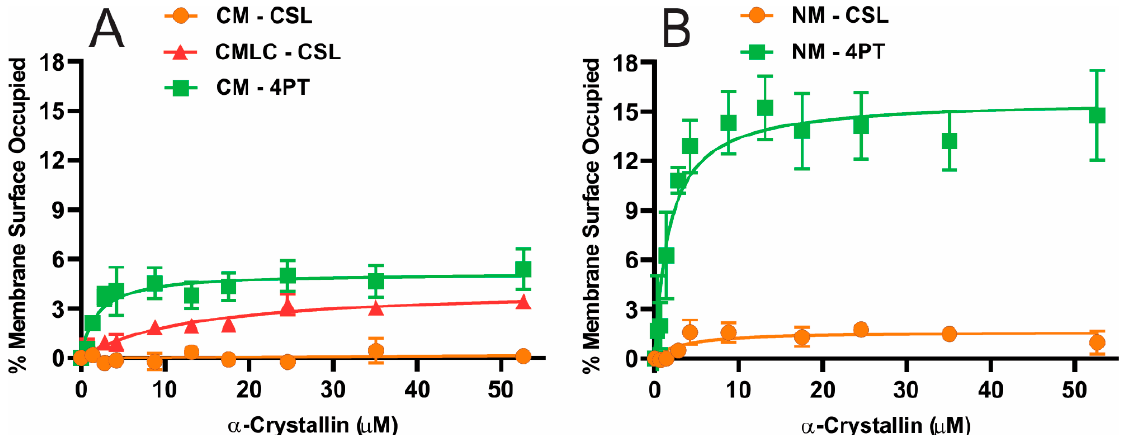
Figure 1. ( A ) The percentage of membrane surface occupied (MSO) by α -crystallin plotted as a function of α -crystallin concentration for the bovine CMs with the cholesterol analog spin-label (CSL) and 4-palmitamido-TEMPO (4PT) spin-label within these membranes and the CMLC with CSL spin-label within the membrane. ( B ) The MSO by α -crystallin plotted as a function of α -crystallin concentration for the bovine NMs with the CSL and 4PT spin-labels within these membranes. The CM and NM were derived from the total lipids extracted from a single lens cortex and nucleus of a two-year-old bovine. The Chol content in the CM was decreased by adding lipids resembling bovine lens lipid composition [63] to prepare the CMLC, as described in Section 4.3. The nitroxide moiety of the 4PT spin-label on the membrane surface (in the aqueous phase close to the membrane surface [88]) detected more MSO for both the CM and NM than the nitroxide moiety of the CSL spin-label below the membrane surface (near the headgroup regions [68,83,89]). The CSL spin-label does not detect α -crystallin binding to the CM; however, it detects the α -crystallin binding to the CMLC. The difference between the MMSO for these membranes with CSL and 4PT spin-labels is statistically significant with p ≤ 0.05. The bovine CM, the CMLC and the NM, with 11.4 mM total lipids, were incubated with varying concentrations of α -crystallin (0–52.6 µ M) for 16 h at 37 ◦ C and the EPR measurements were recorded at 37 ◦ C. Results are the mean ± standard deviation ( σ ) from at least three independent experiments.